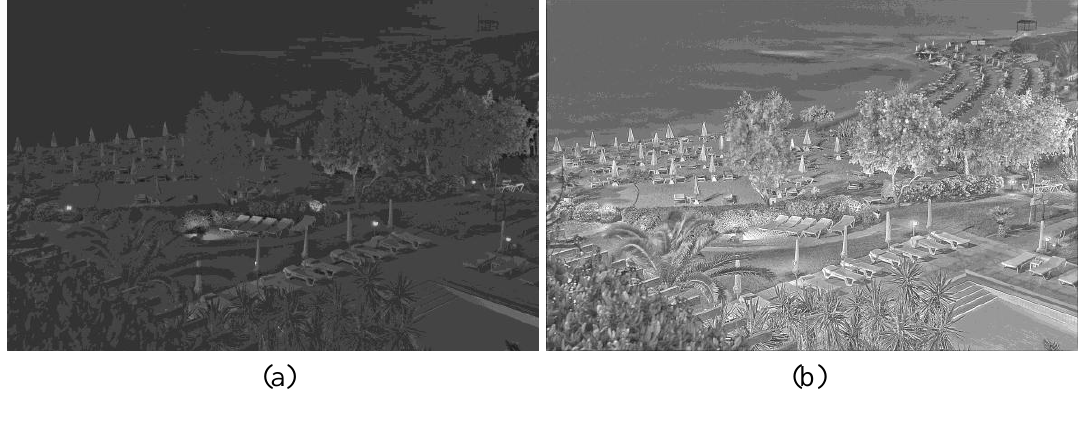
Figure 10. (a) Image generated using the bilateral filtering tone mapping algorithm. (b) Image generated using the automated version of the bilateral filter tone mapping algorithm to increase amount of visual information seen by the viewer.